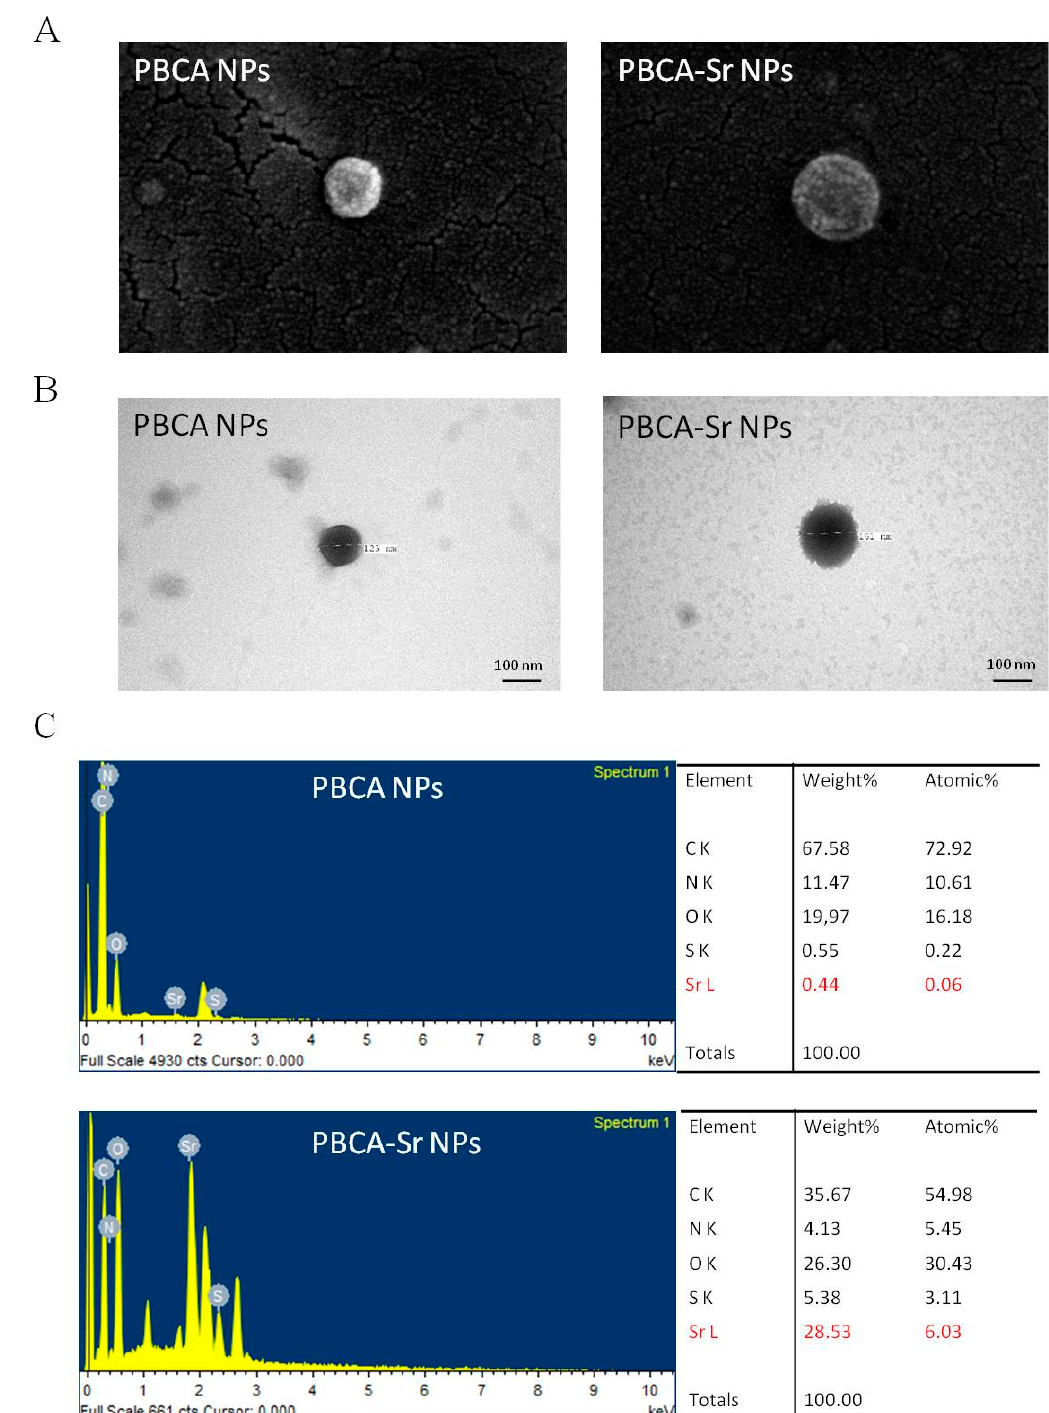
Figure 1. Analysis of PBCA-Sr. ( A ) FE-SEM images of PBCA NPs and PBCA-Sr NPs. Magnification: 200,000 × . ( B ) TEM images of PBCA NPs and PBCA-Sr NPs. Magnification: 200,000 × . ( C ) EDS analysis for PBCA NPs and PBCA-Sr NPs.